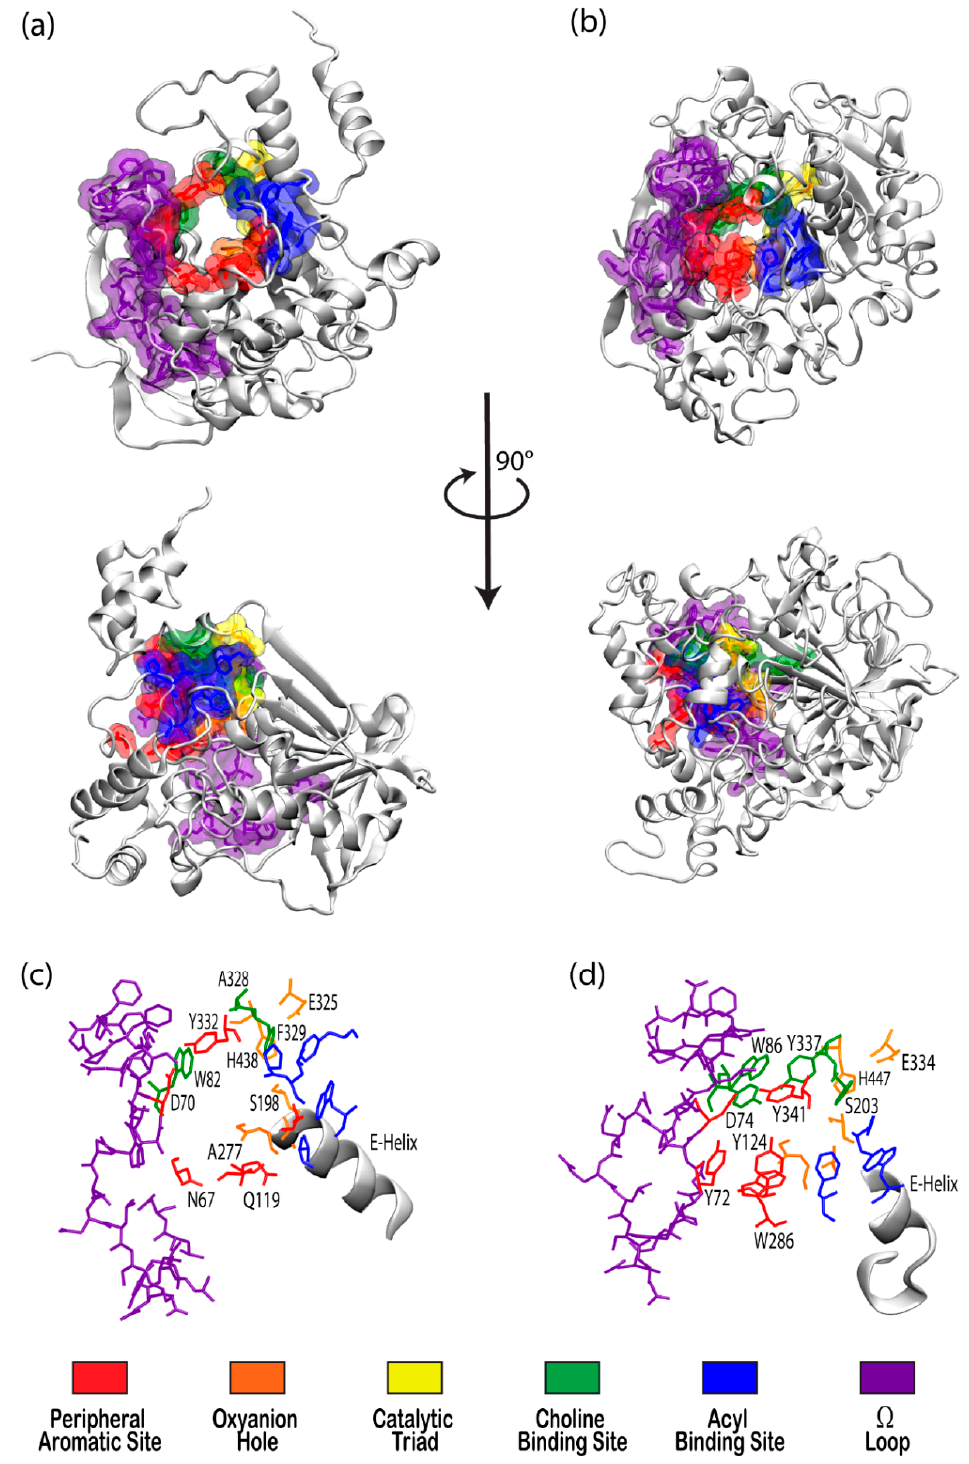
Figure 1. Visualizations of ( a ) butyrylcholinesterase (BChE) (PDBID 1P0I) and ( b ) acetylcholinesterase (AChE) (PDBID 1B41) in white ribbon mode with residues in notable binding sites shown as semi- transparent van der Waals surfaces colored according to the key. Top panels present views directly into the active site gorges with structures in the center panel rotated 90 ◦ about the vertical axis. Bottom panels present magnified views of the binding site regions of ( c ) BChE and ( d ) AChE with key residues